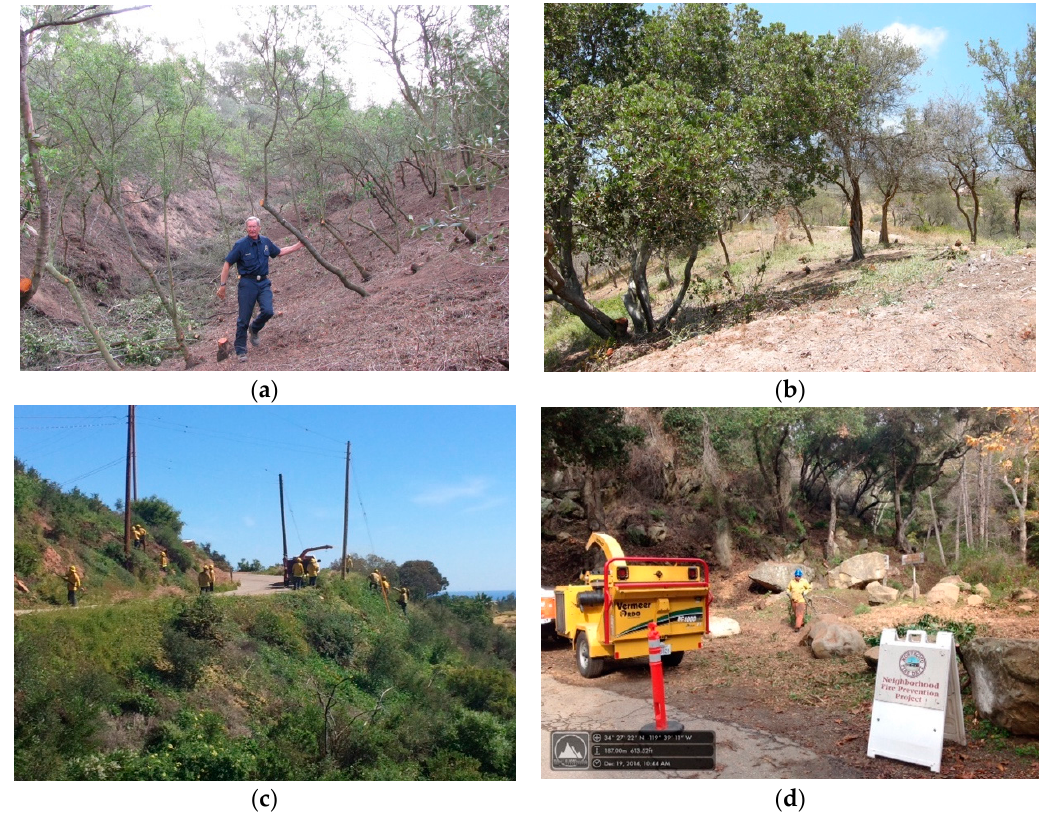
Figure 4. Examples of fuel reduction activities undertaken in Montecito: ( a ) a shaded fuel break on private property with Wildland Fire Specialist, ( b ) understory clearing and thinning on private property, ( c ) roadside fuel reduction, and ( d ) chipping equipment in use as part of the Neighborhood Chipping Program. Photos courtesy of Montecito Fire Protection District.